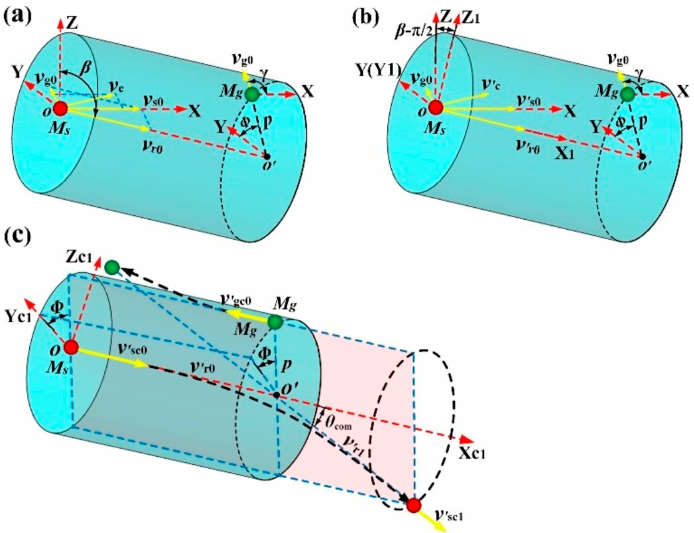
Figure 5. Scattering collision between sputtered Cu atom (M s ) and background gas atom (M g ) with specific initial velocities. ( a ) Initial velocities and positions of M s and M g in the laboratory coordinate system XYZ; ( b ) initial velocities and positions of M s and M g in the laboratory coordinate system X 1 Y 1 Z 1 ; ( c ) scattering collision between M s and M g in the center of mass coordinate system X c1 Y c1 Z c1 when the coordinate system X 1 Y 1 Z 1 floats with the mass center of colliding atoms.